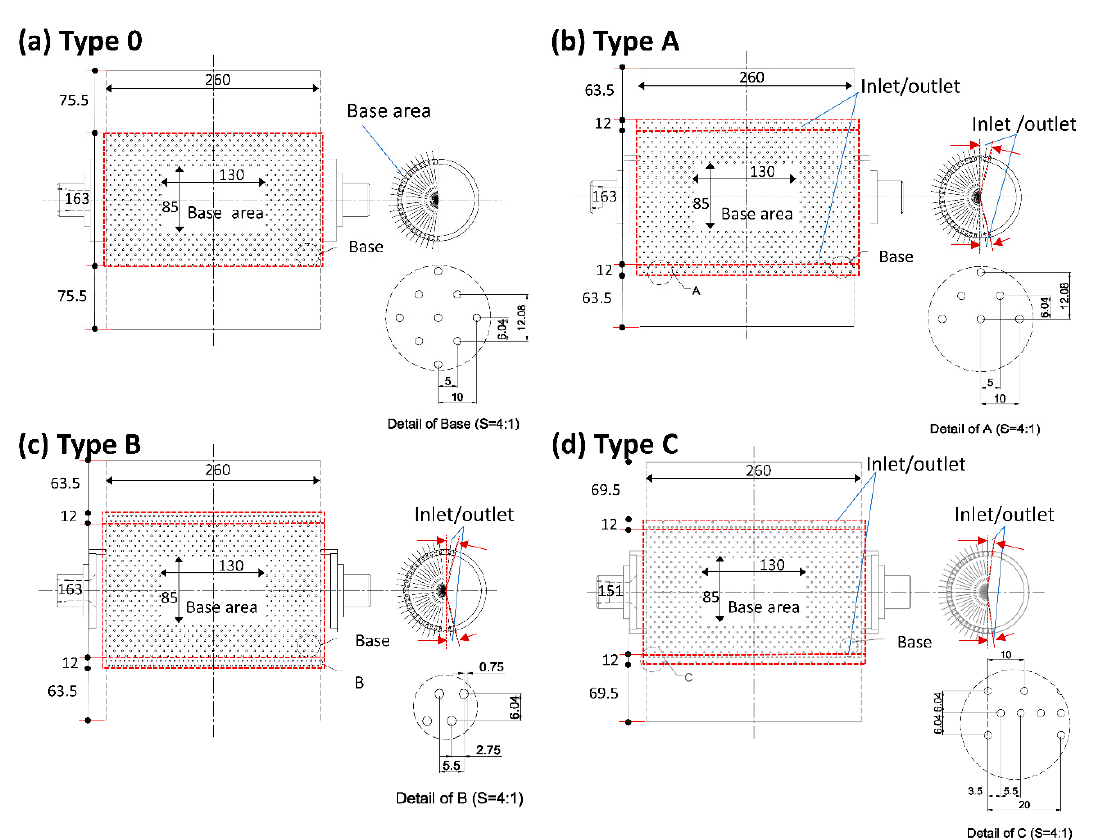
Figure 1. Candidate air-bar designs for the FSI simulations. ( a ) Type 0 is the base design with a 180-degree hole distribution with a density of 0.026. ( b ) Type A is an alternative design based on Type 0, with additional holes at the inlet and outlet with a density of 0.026 in two rows. ( c ) Type B is an alternative based on Type 0, with additional holes at the inlet and outlet with a density of 0.094 in two rows. ( d ) Type C is an alternative based on Type 0, with additional holes at the inlet and outlet with densities of 0.052 and 0.013 in two rows, respectively.